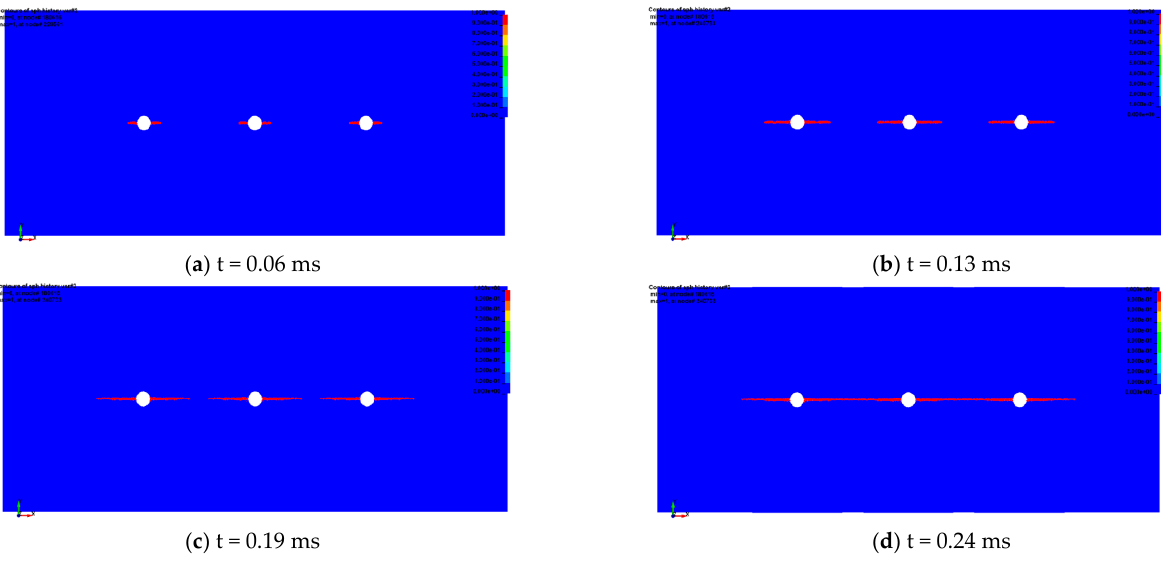
Figure 22. Stress evolution process of 400 mm spacing multi-hole shaped charge blasting.